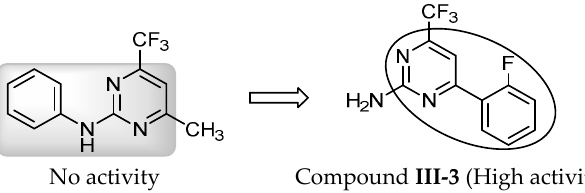
Figure 3. Compared to core framework of anilinopyrimidines and compound III-3 .